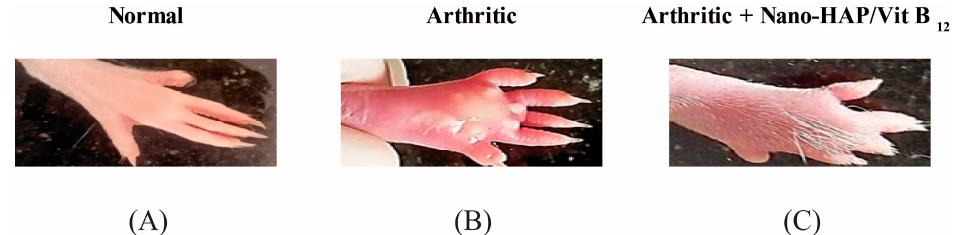
Figure 3. Adsorption of Vit B 12 on the (0 1 0) HAP surface as obtained from the Monte Carlo simu- lation.